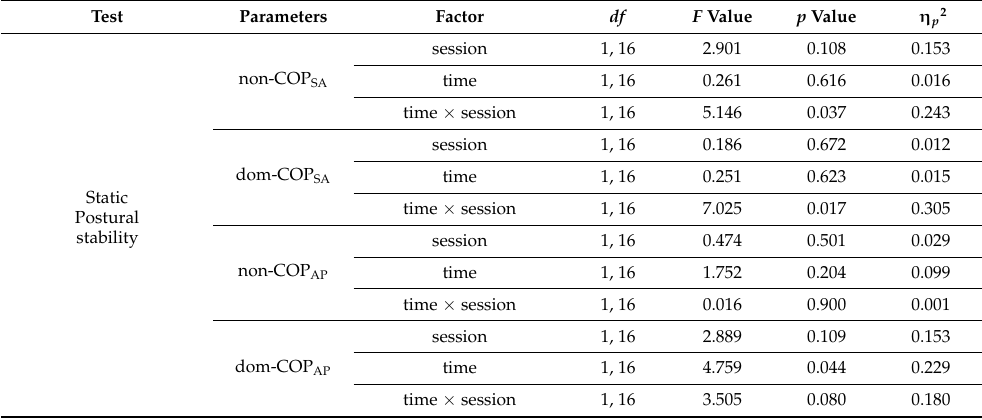
Table 1. Results of the repeated-measures ANOVAs for static and dynamic postural